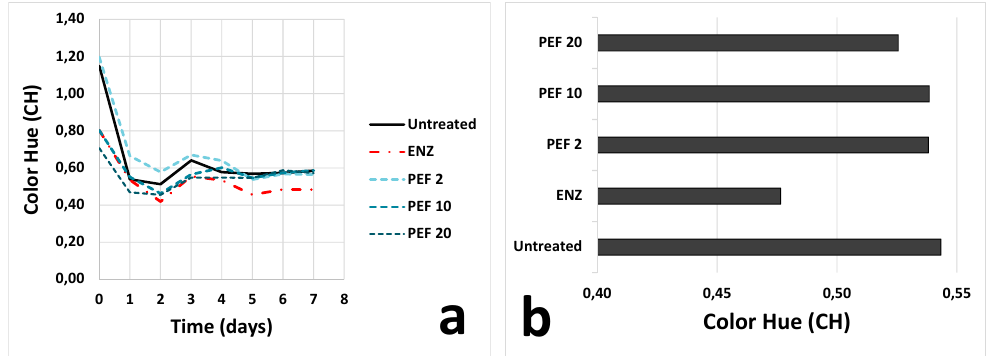
Figure 2. Trend measured for color hue in the samples analyzed during skin maceration up to draining/pressing (day 7) ( a ) and at the end of alcoholic fermentation (day 9) ( b ). Refer to Figure 1 for sample codes.